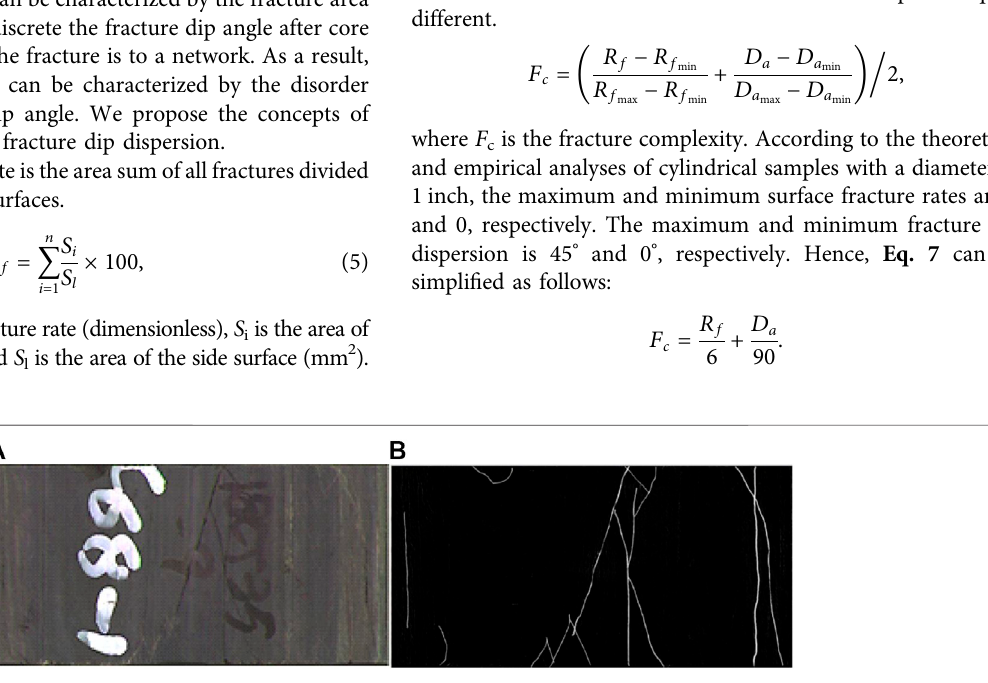
FIGURE7|(A) Anoriginalpost-fraccoreimage.Fracturesaredif fi culttobeidenti fi edduetotheimageresolution. (B) Apost-fraccoreimagepreprocessedwiththe method in Section 2.3.3. The fractures are clearly identi fi ed.